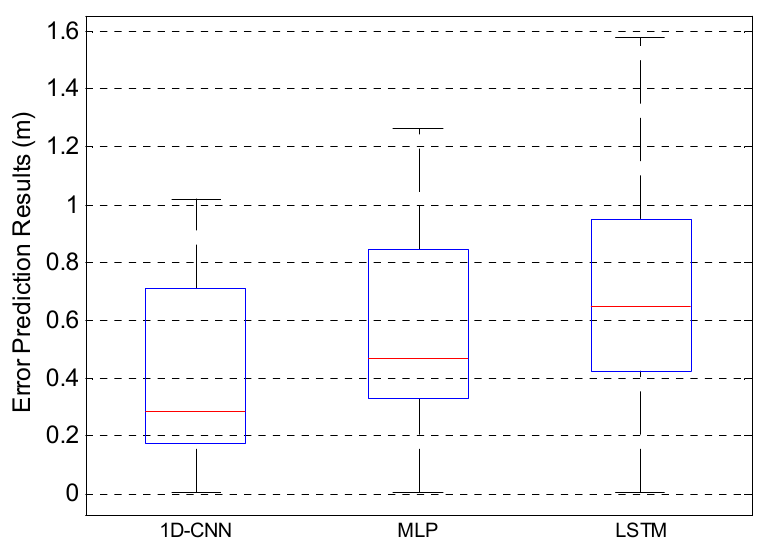
Figure 9. Accuracy Comparison of Different Models.